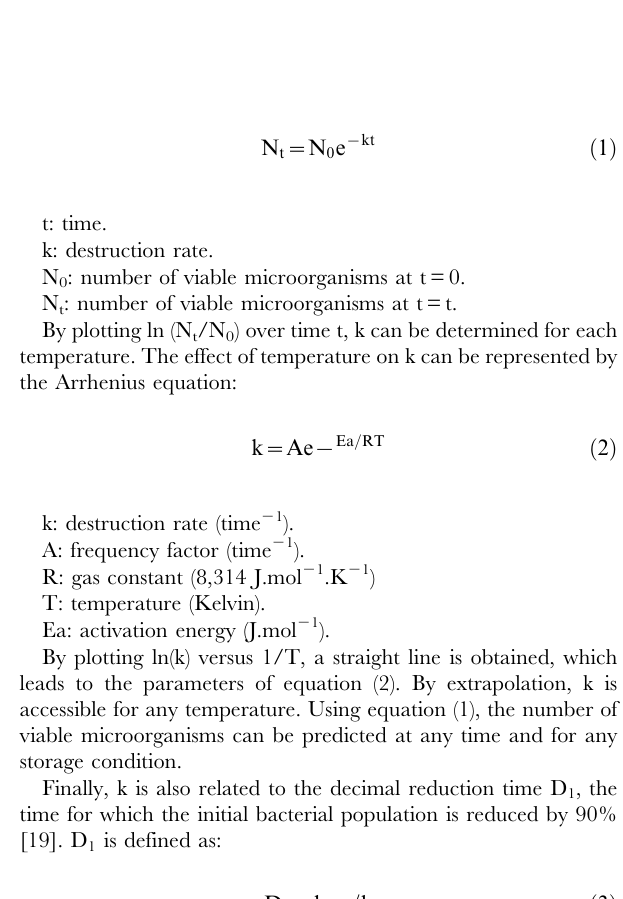
Figure 3. Effect of storage conditions on bacterial stability within Bacilor H ( Lcrrestituo H capsules). Plot of ln(N t /N 0 ) for the batches of Bacilor H ( Lcr restituo H capsules) against time and temperature 20 u C ( ¤ ), 25 u C ( regulation (ICH Guideline Q1A).